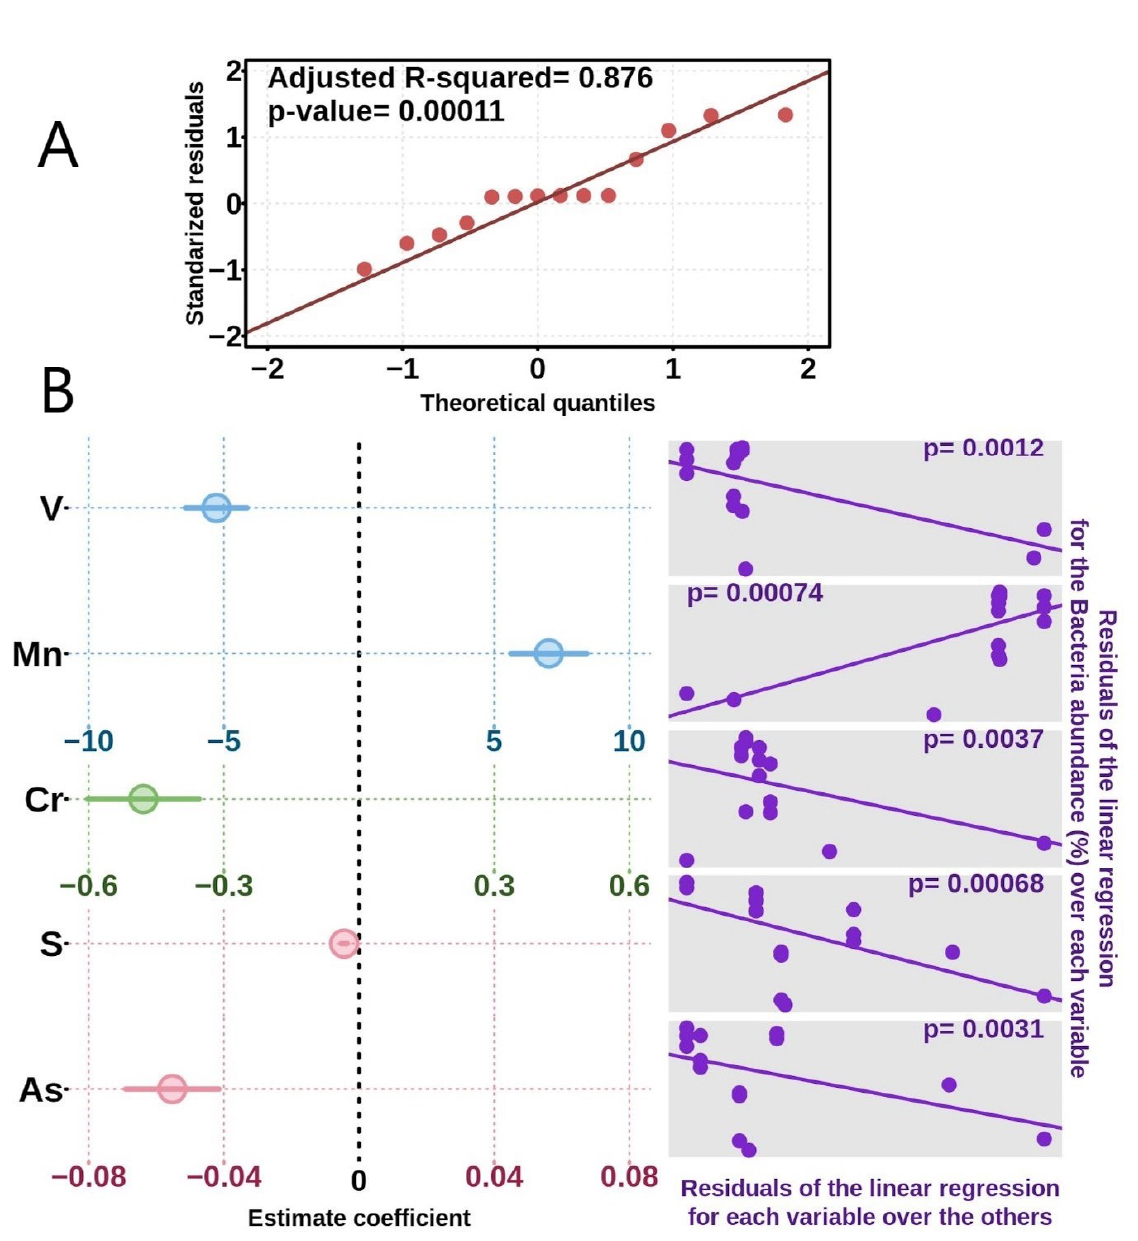
Figure 3. Analysis of the influence of metals on the bacterial relative abundance with multiple linear regression. The best-fitting model included V, Mn, Cr, S and As as the best predictor variables. ( A ) Quantile–quantile plot showing the accuracy of the best obtained model, after analysing all metals profiles. ( B ) The estimate coefficient of each predictor variable (metal) is shown on the left. Each colour represents a different x-axis scale. On the right side of each variable, the corresponding variable plot is